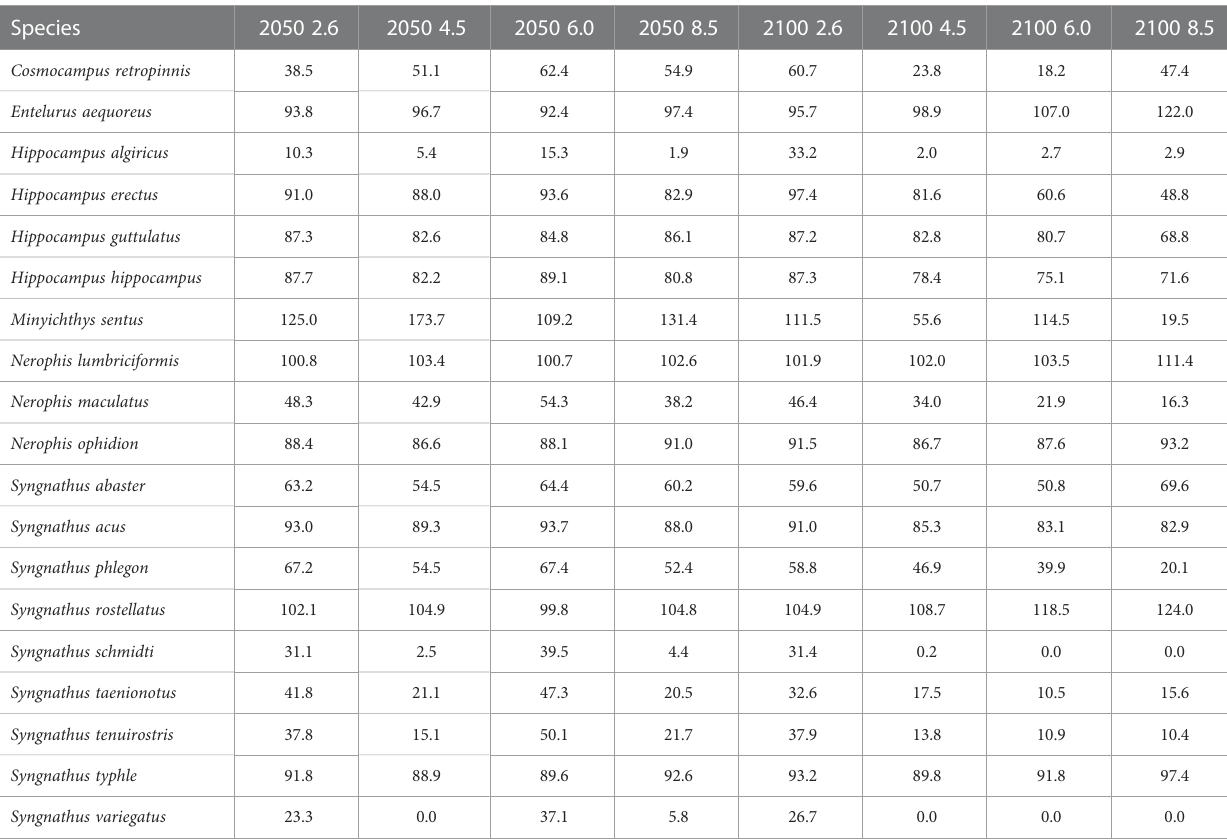
TABLE 1 Change in potentially suitable areas for European syngnathids (as % of retained present range), in two time periods (2040-2050, 2090-2100) and according to the four selected RCPs (2.6, 4.5, 6.0, 8.5). Species